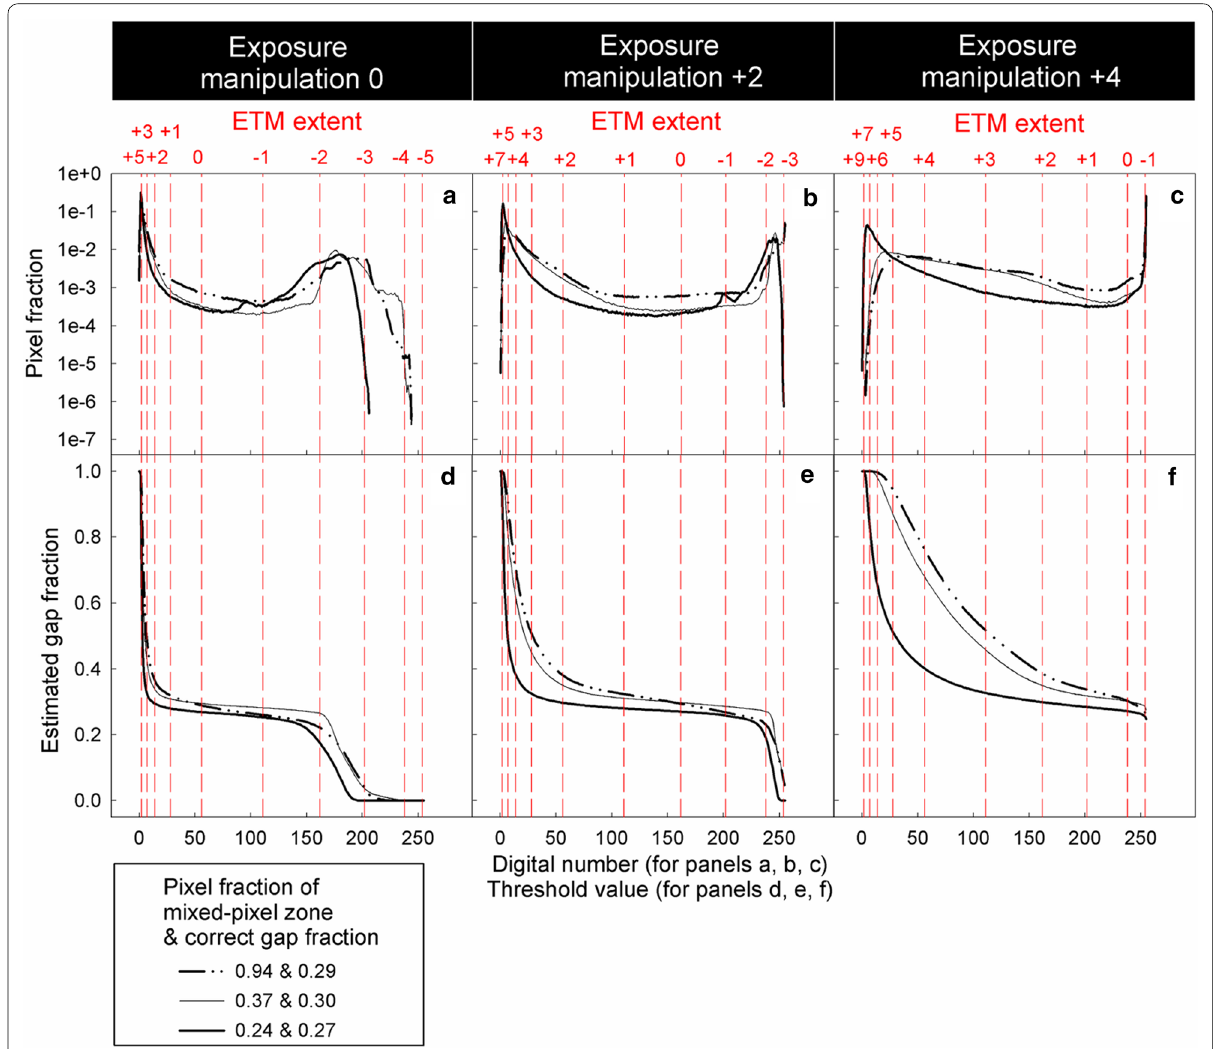
Fig. 8 a – c Frequency distribution of pixel fraction along the greyness gradient of real CHPs, and d – f estimated gap fraction under different ETM extents. The figure is derived from CHPs of three real canopies with similar gap fraction (0.29, 0.30 and 0.27), with proportion pixel of mixed‑pixel zone (i.e. mixed‑pixel zone length) of 0.94, 0.37 and 0.24, respectively. Note log scale used on y‑axis in panels a – c . The unit of the exposure manipulation, thresholding manipulation and ETM extent is